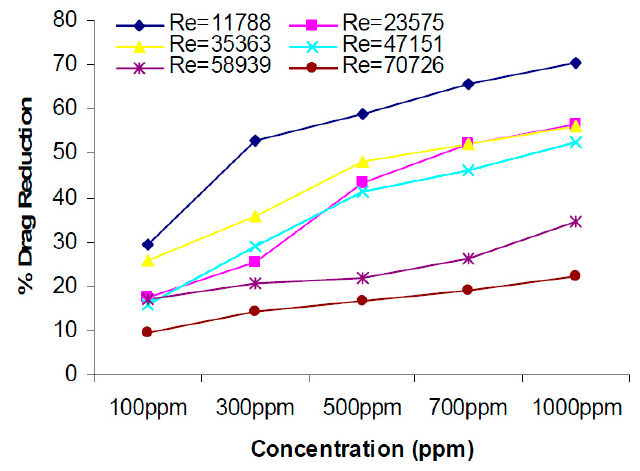
Figure 15. Effect of concentration on the percentage drag reduction for Okra-Natural Mucilage dissolved in water flowing through 0.015 m ID pipe, reprinted with permission from [95]. Copyright Centre for Graduate Studies, Universiti Malaysia Pahang, 2009.